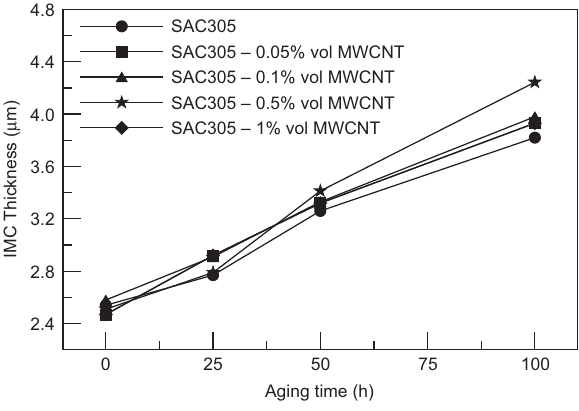
Figure 5 IMC thickness of Sn-Ag-Cu-MWCNT systems with aging time at 240 °